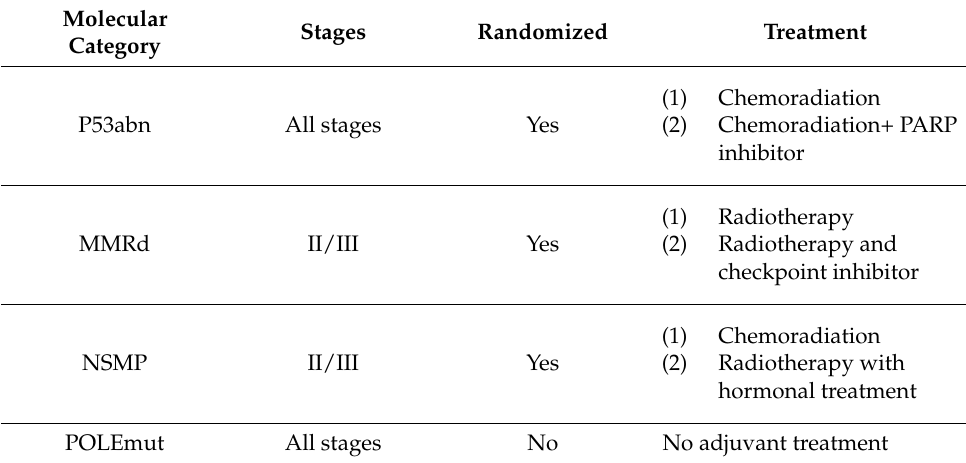
Figure 3. Study design of the PORTEC-4a trial. Reprinted with permission from “PORTEC-4a: international randomized trial of molecular profile-based adjuvant treatment for women with high- intermediate risk endometrial cancer [52]. HIR high intermediate risk, EBRT external beam radiation therapy, POLE polymerase epsilon, MMRd mismatch repair deficiency, LVSI lymphovascular space invasion, L1CAM L1 cell adhesion molecule, CTNNB1 beta catenin 1. ( A ) Study design of the PORTEC-4a trial. ( B ) Decision tree of the molecular-integrated risk profile. Table 4. Study groups of the RAINBO trial